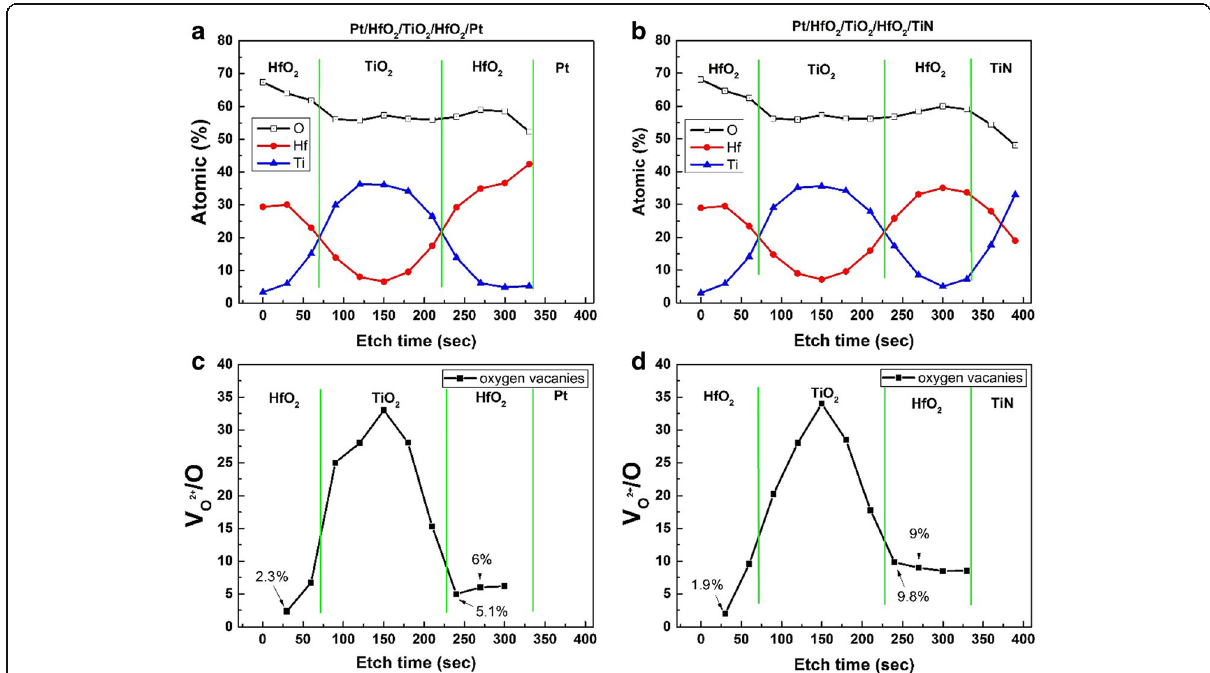
Fig. 7 XPS depth profiles of HfO 2 /TiO 2 /HfO 2 on Pt- and TiN-coated Si by Ar ion etching. a HfO 2 /TiO 2 /HfO 2 on Pt-coated Si. b HfO 2 /TiO 2 /HfO 2 on TiN-coated Si. The depth distribution of oxygen vacancy concentration ( V O 2+ /O) determined from XPS spectra for HfO 2 /TiO 2 /HfO 2 on Pt- and TiN- coated Si. c HfO 2 /TiO 2 /HfO 2 on Pt-coated Si. d HfO 2 /TiO 2 /HfO 2 on TiN-coated